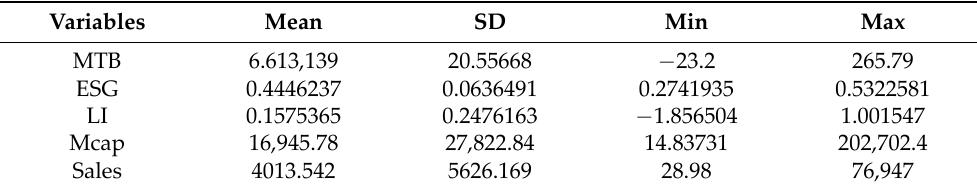
Table 2. Descriptive Statistics.